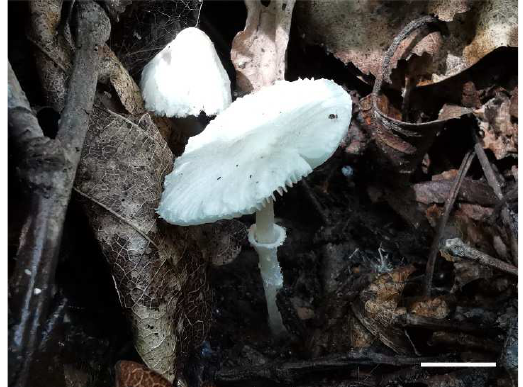
Figure 8. Basidiomata of Leucoagaricus candidus . (CFSZ 20964). Scale bars: 1 cm.